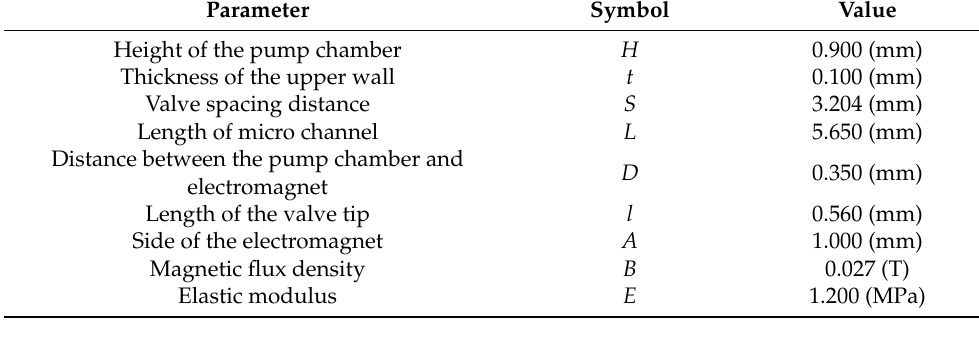
Figure 3. Duckbill valve model in 2D with its main dimensions. Table 1. Properties of duckbill valve model.